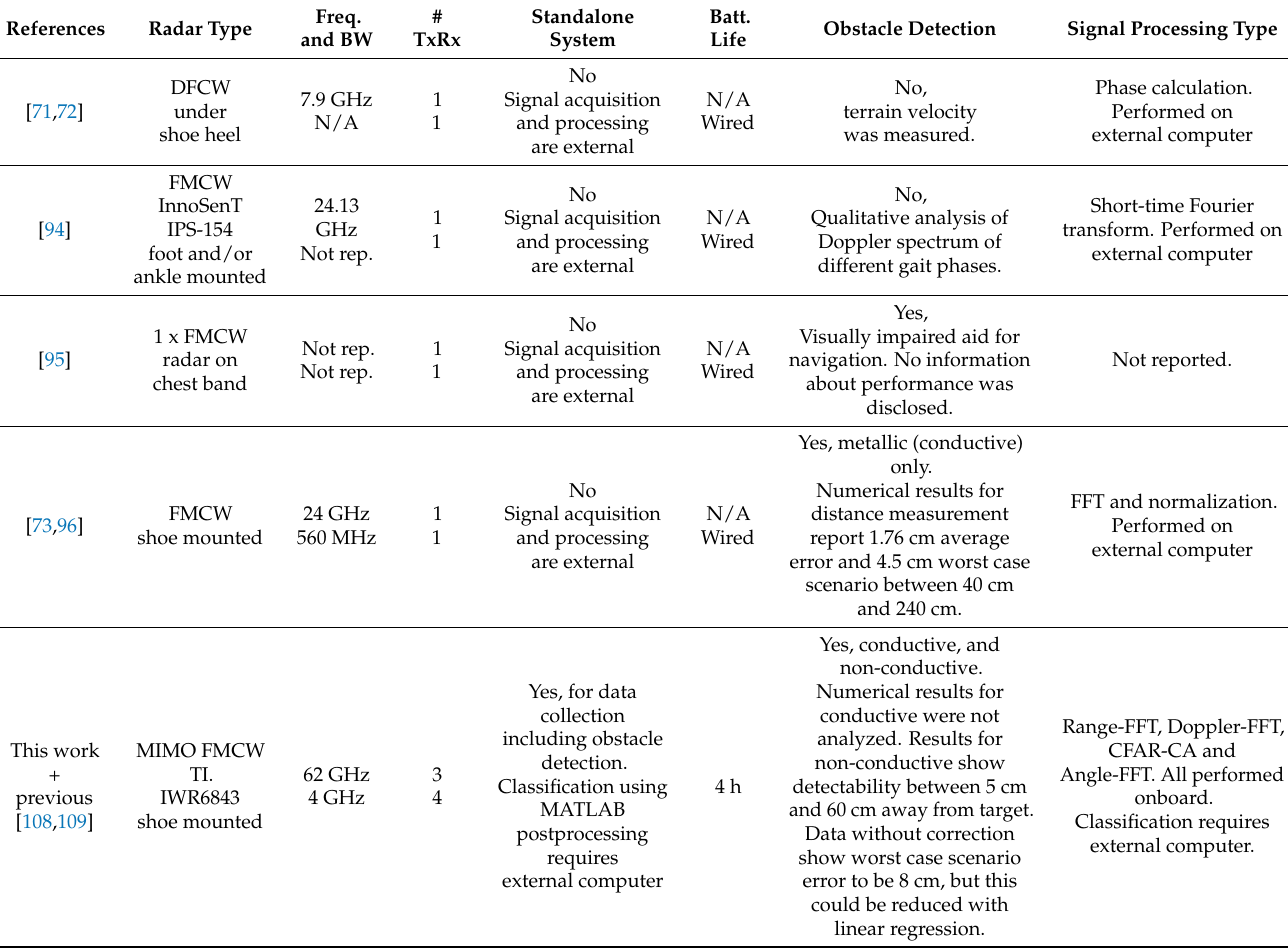
Table 3. Comparison of wearable radar in this work with previous related